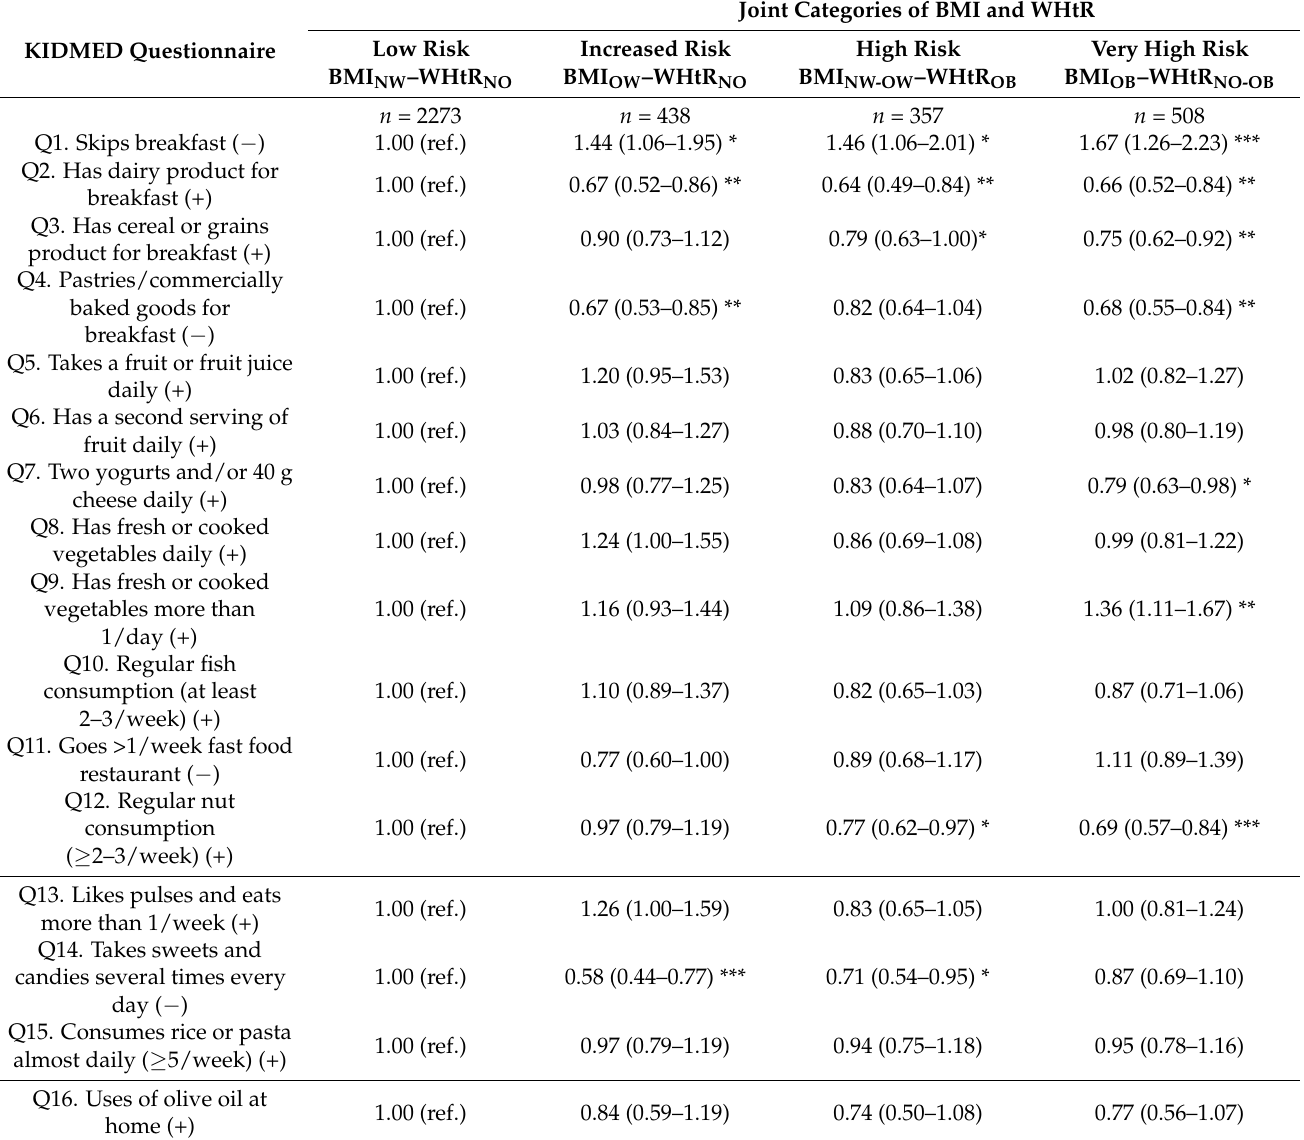
Table 4. Odds ratios (and 95% confidence intervals) from logistic regression showing the correlation of children’s “yes” answers in the KIDMED questionnaire and children’s categories of BMI and